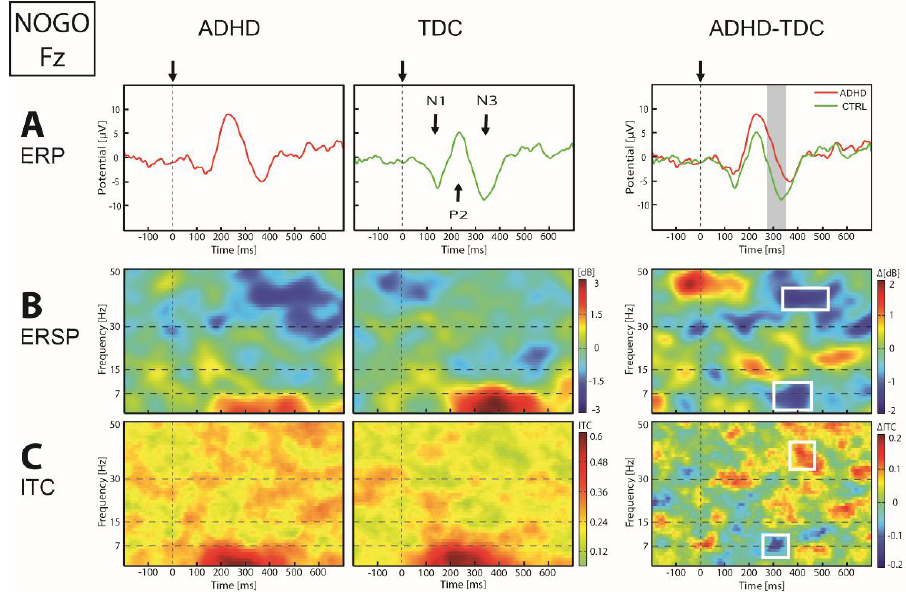
Figure 5. ERP ( A ), ERSP ( B ) and ITC ( C ) in Fz electrode in response to Nogo stimulus. On the ERP panel: arrows and vertical dotted lines indicate stimulus onset, vertical gray bands indicate significance p < 0.05. On the ERSP and ITC panel: vertical dotted line indicate stimulus onset, horizontal dotted lines define frequency bands, and white square indicate significance p < 0.05.